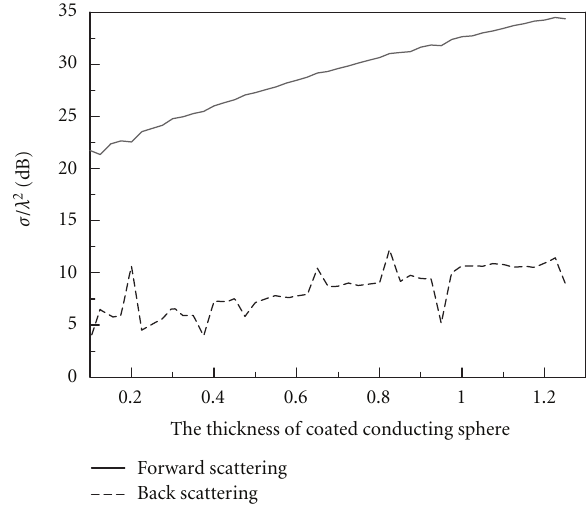
Figure 5: Radar cross sections (RCSs) versus the thickness of the uniaxial SNG medium in the forward (solid curve) and in the back (dashed curve) directions, when inner radius is fixed at a 2 = 0 . 75 λ . The parameters of the uniaxial SNG coating of the conducting sphere are assumed to be (cid:3) t = − 1 . 5 (cid:3) 0 , (cid:3) t = − 3 (cid:3) 0 , μ t = 3 μ 0 , and . 5 μ μ z = 1 0 ,